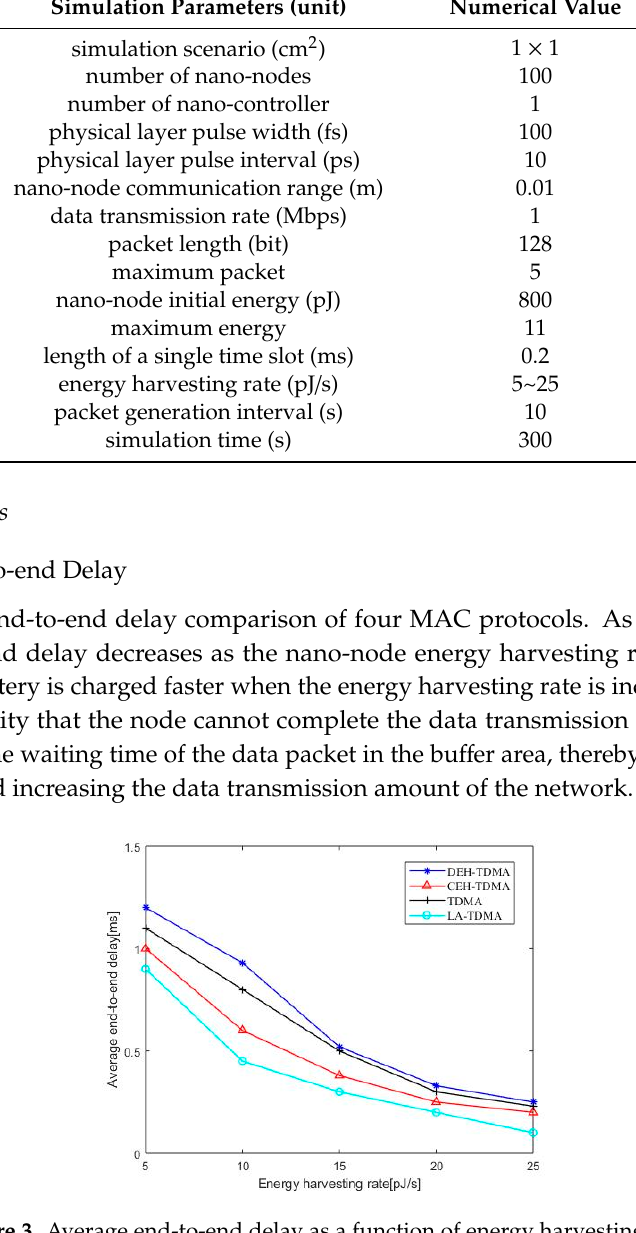
Figure 3. Average end-to-end delay as a function of energy harvesting rate.